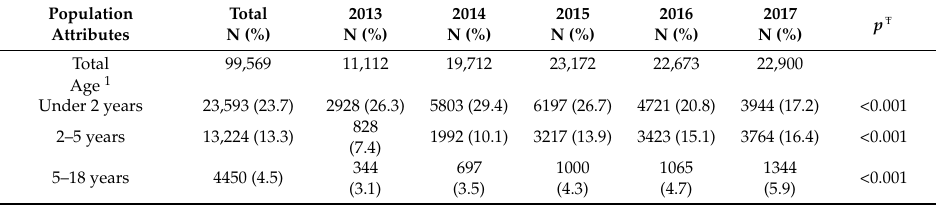
Table 1. Patient characteristics and medical visit outcomes at Terem Refugee Clinic, 2013–2017.